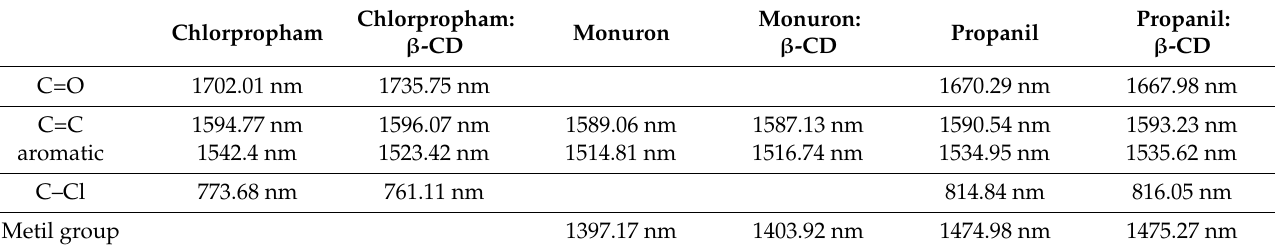
Figure 4. FT-IR spectra recorded for the co-precipitation complexes of Chlorpropham ( a ), Monuron ( b ), and Propanil ( c ) with β -CD are compared, the same spectra recorded for the physical mixture of each pesticide with β -CD and each pesticide or the β -CD alone. Table 2. FT-IR bands for the studied molecules and their complexes.